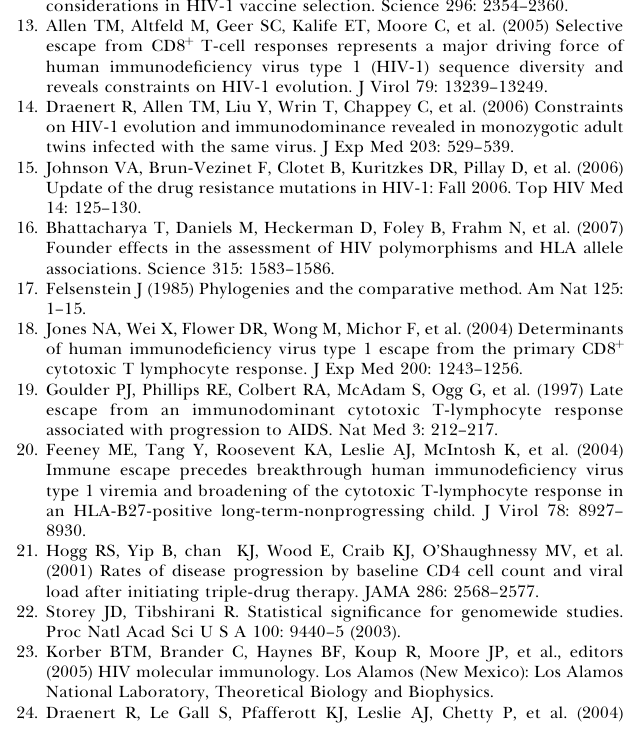
Table S1. Full List of HLA Allele-Associated HIV Polymorphisms in Functional and Accessory/Regulatory Proteins Investigated (A) Full list of HLA allele-associated HIV polymorphisms in Nef